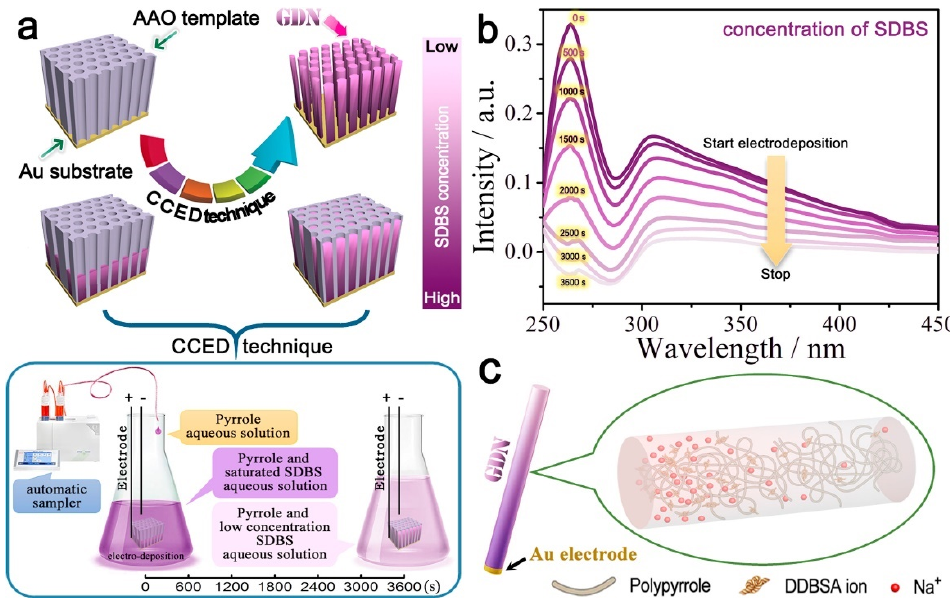
Figure 3. ( a ) Schematic illustration of the template growth of GDNa, ( b ) Ultraviolet spectrometry at different stages of electrodeposition solution, ( c ) Model diagram single GDNw [75]. Copyright 2018 Nano Energy.